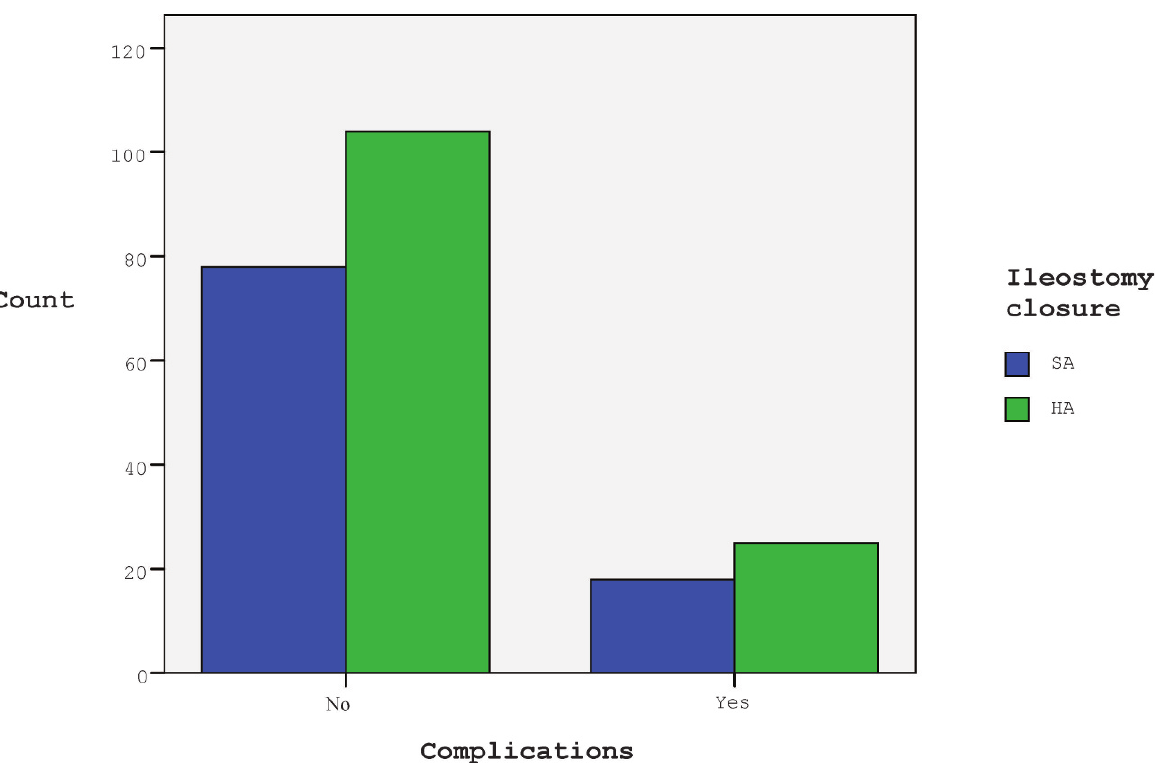
Figure 1 - A statistical analysis of the overall postoperative complications according to the surgical anastomotic technique used for the ileostomy closure.